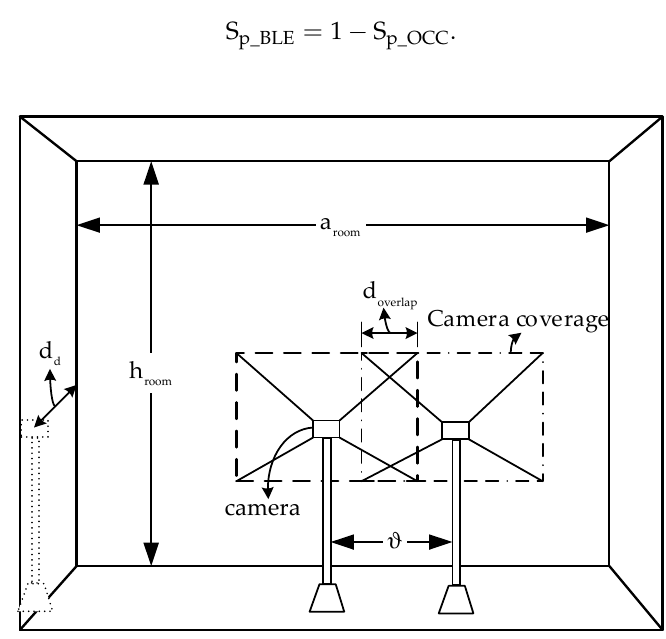
Figure 5. Considered indoor scenario for the selection mechanism.